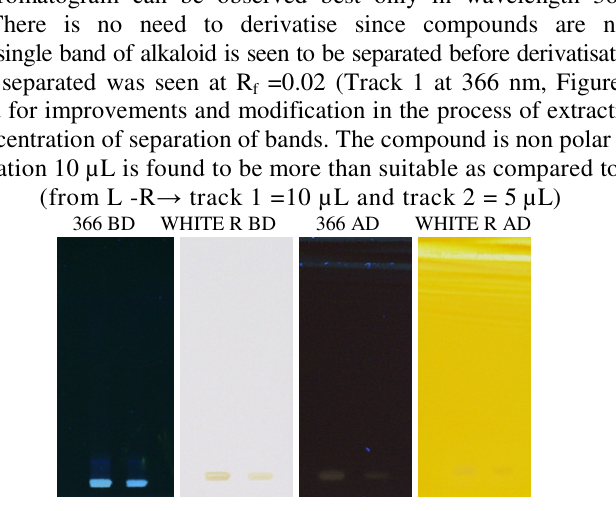
Figure 1. (Plate no 1) HPTLC of bitter principle (AD: After derivatisation; BD: Before derivatisation )